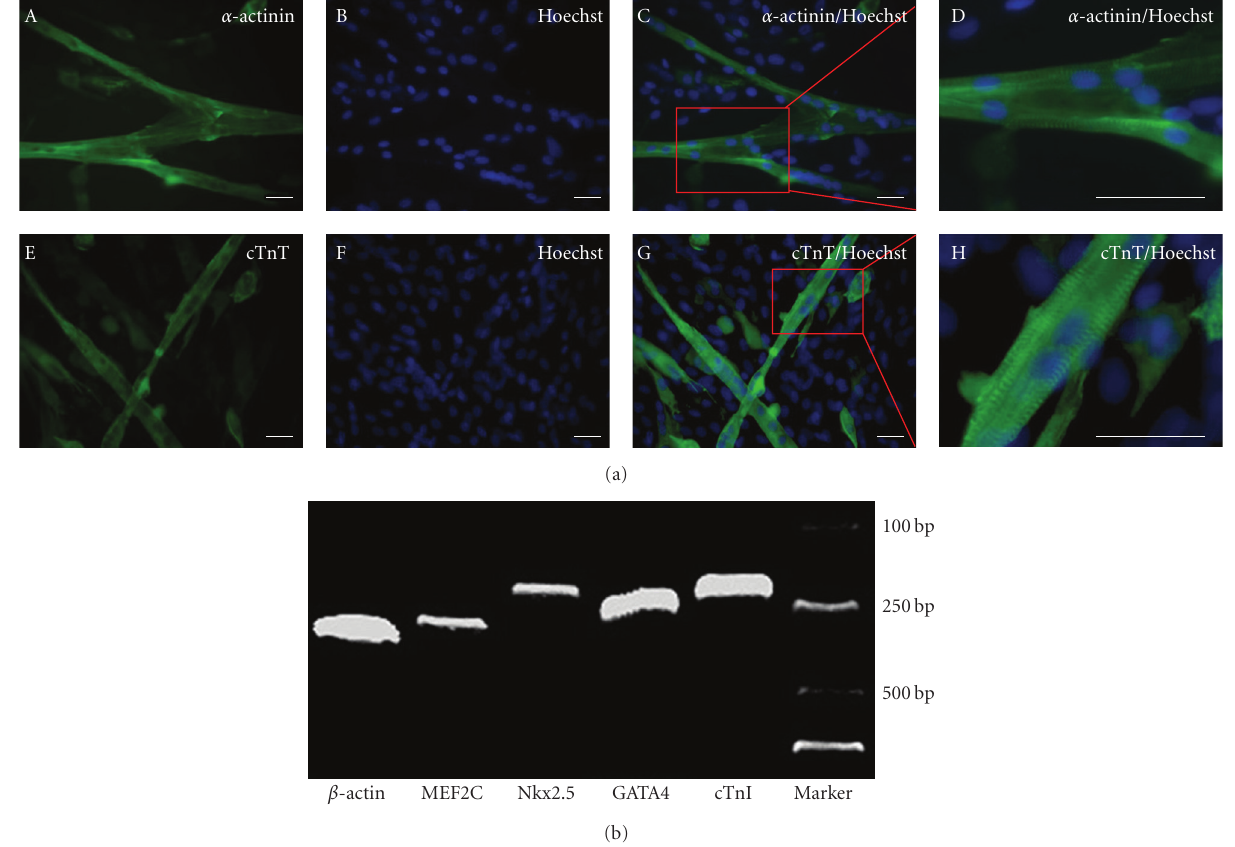
Figure 4: (a) Immunostaining of di ff erentiated cells for cardiac-specific antibodies. Di ff erentiated cardiomyocytes-like cells were specifically stained with anti α -sarcomeric actinin A–D, and anticardiac troponin A–I antibodies; the transverse striation can be clearly observed under high magnification microcopy (D and I, 4 magnifications of red frame in C and G, resp.). Furthermore, no specific staining was obtained with the antiMyoD (data not shown) (Bar = 50 μ m). (b) Expression of cardiac-specific genes in the di ff erented cells analyzed by